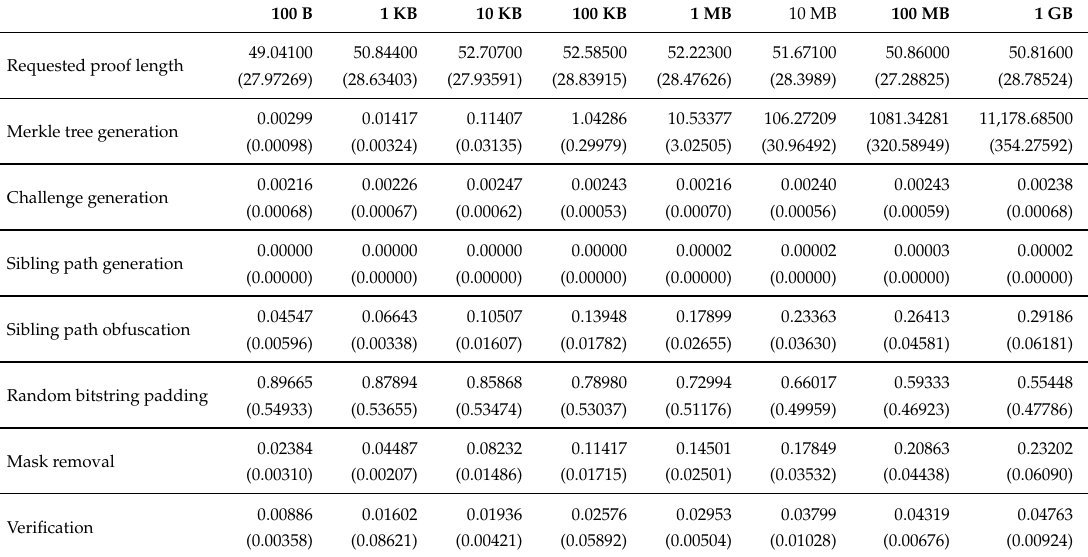
Table 5. Average computation time (ms) of the proposed authentication scheme by data size (standard deviation in